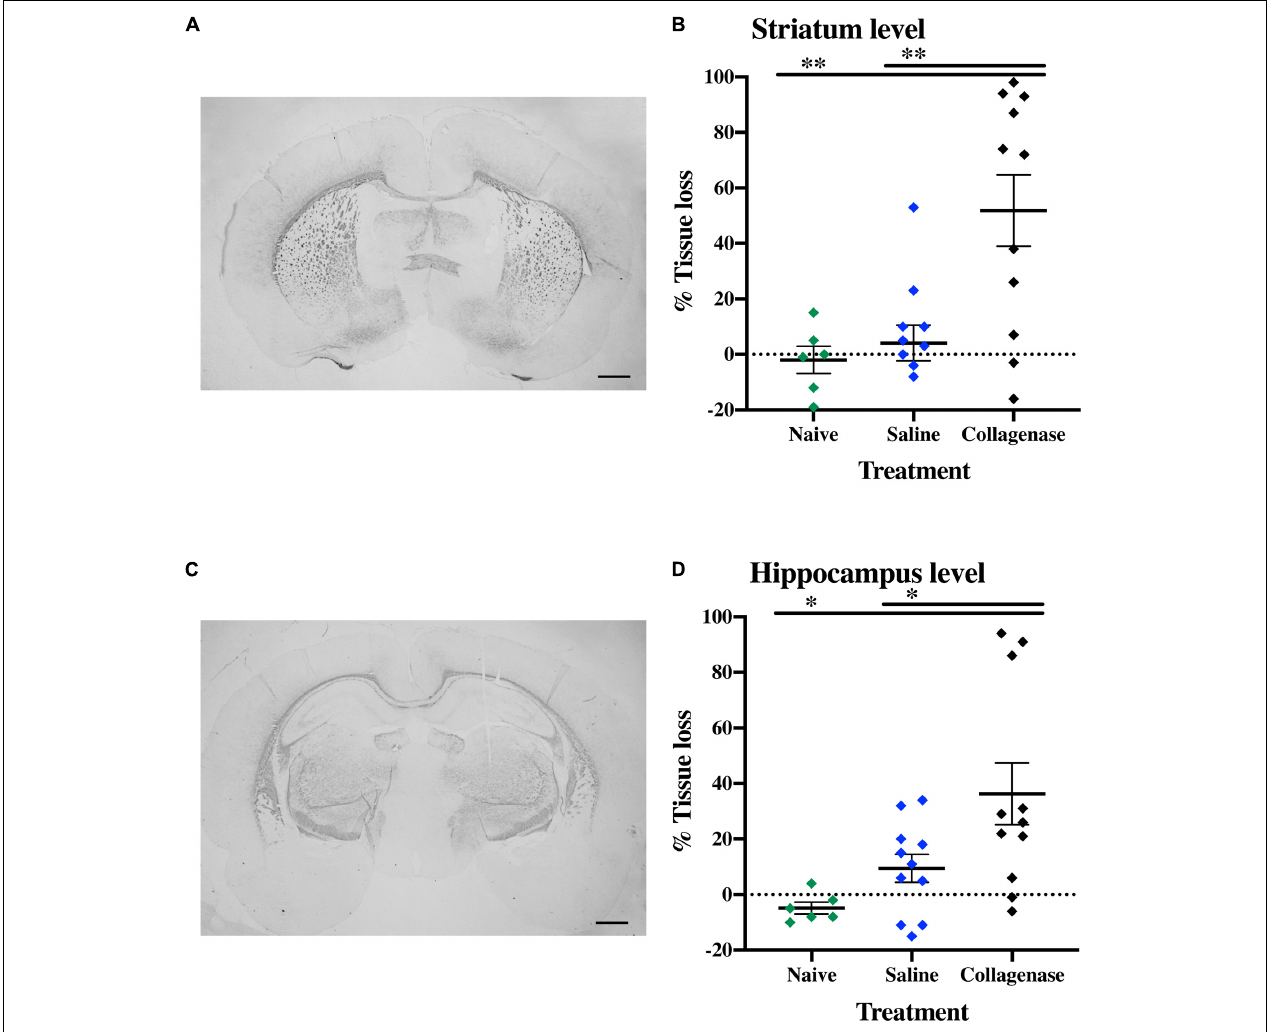
FIGURE 6 | White matter injury at P16. (A) Representative striatum level MBP-stained whole brain micrograph of 0.3 U collagenase-injected rats and (B) corresponding graph demonstrating collagenase-mediated reduction in subcortical white matter at P16. (C) Representative MBP-stained whole brain micrograph of 0.3 U collagenase-injected rats at the level of the hippocampus and (D) associated graph showing subcortical white matter in the collagenase group at P16 ( n = 12). Both naïve ( n = 10) and saline ( n = 10) animals were used as control groups. Data represented as individual animals ± SEM and analyzed using one-way ANOVA followed by Tukey’s multiple comparison test. ∗ P < 0.05 and ∗∗ P < 0.01. Scale bar = 1